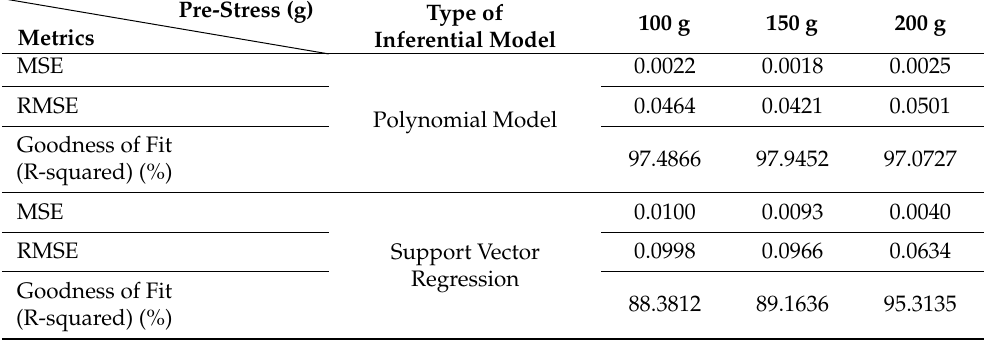
Table 10. Metrics of inferential models at different pre-stresses.